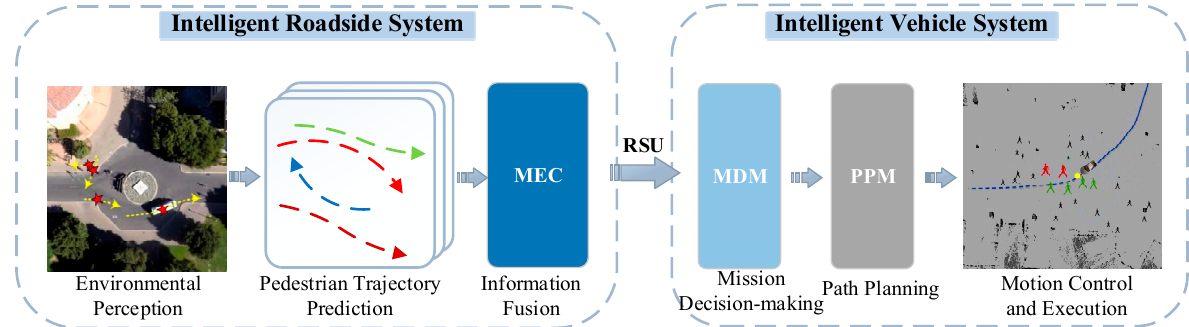
Figure 7. The autonomous driving obstacle avoidance system is based on pedestrian trajectory prediction, where MDM indicates the module of mission decision-making, and PPM indicates the module of path planning.